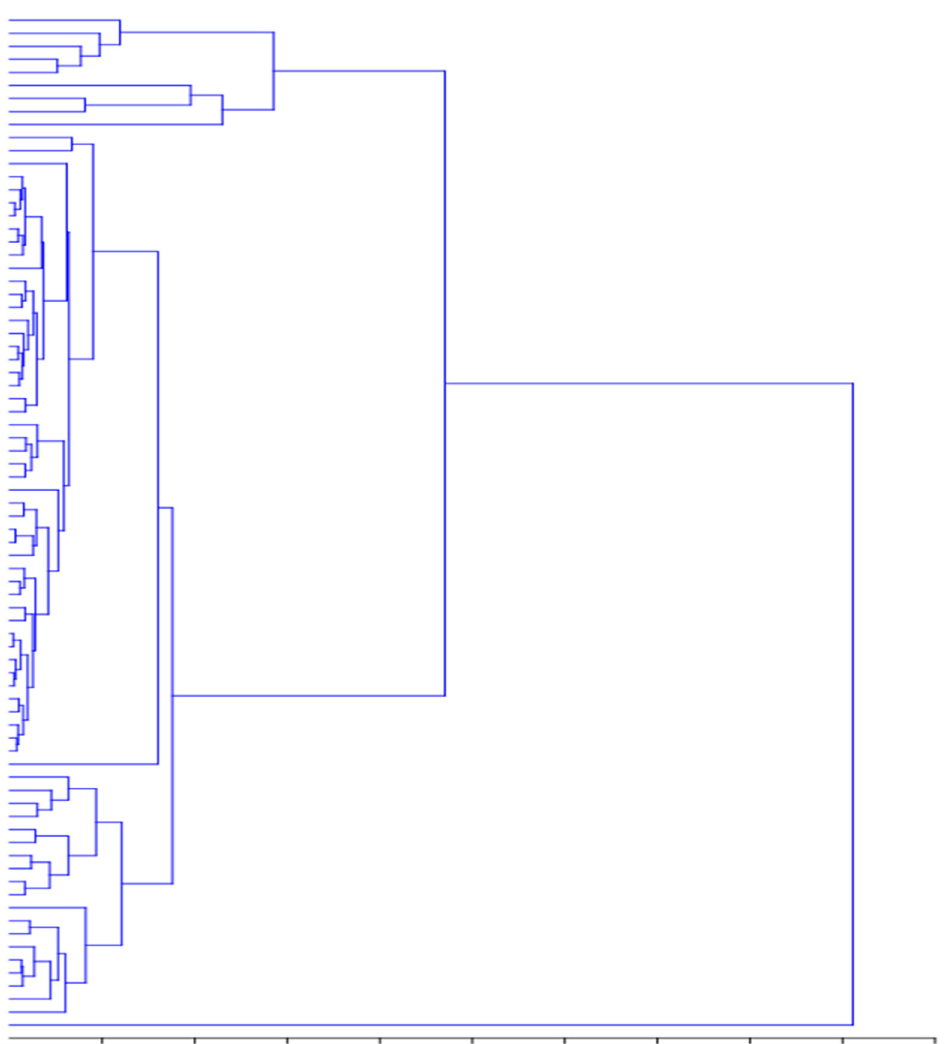
Figure 4. Dendrogram of morphological traits using UPGMA clustering in the selected accessions of S. bicolor .